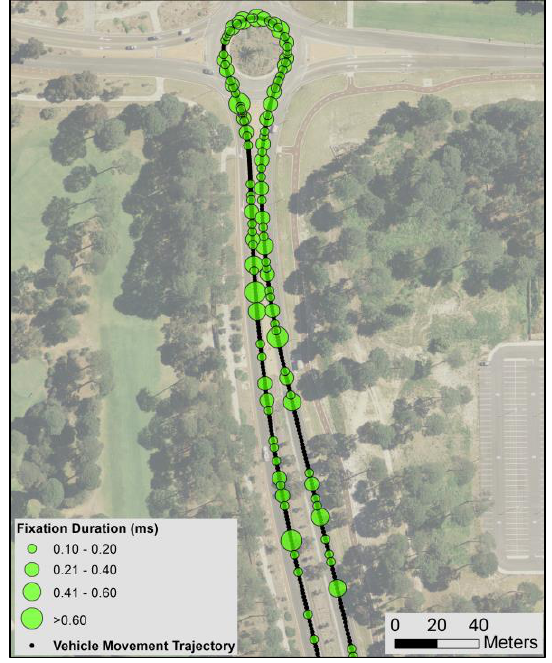
Correlation coefficients between visual capacity and fixation du- ration (SUM Duration /Manoeuvre time) at different driving scenar- ios (*p<.05; **p<.01, 2-tailed).